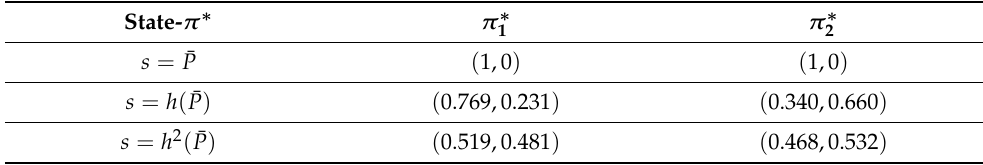
and π ∗ for unreliable 2 1